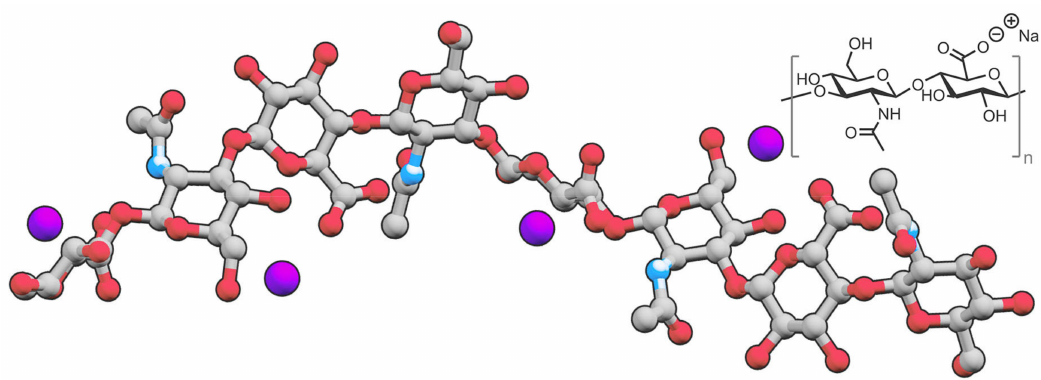
Figure 1. Structure of sodium hyaluronate, a salt derived from hyaluronic